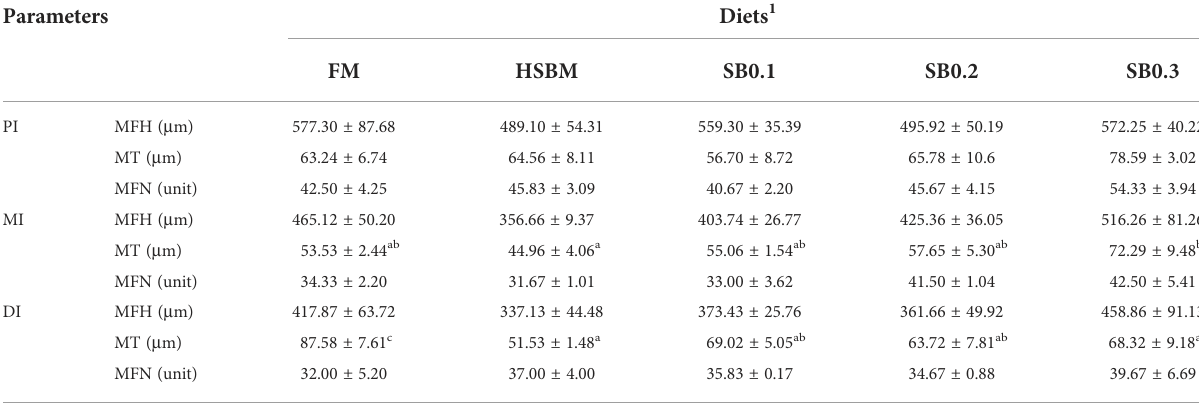
TABLE 7 Effects of sodium butyrate (SB) addition in high soybean meal (SBM) diets on the intestinal morphology of groupers in a 56-d feeding period.